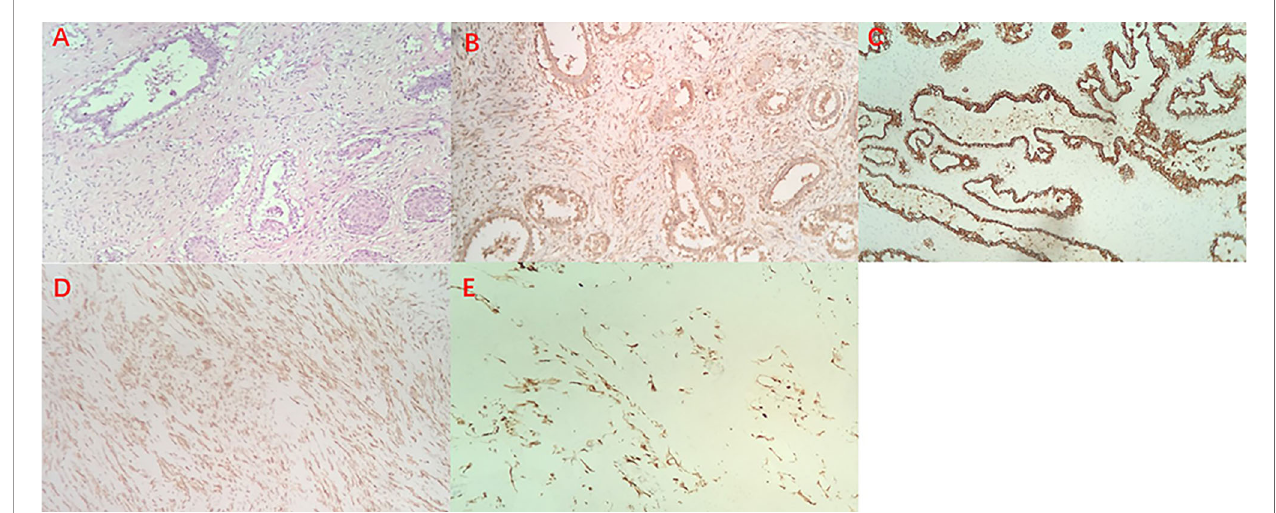
FIGURE 2 | Hematoxylin and eosin staining of the borderline Phyllodes Tumor of Breast (original magni fi cation ×100) (A) , Immunohistochemistry staining revealed positive expression of IGF-2 (B) , CK (C) , SMA (D) and Desmin (E)